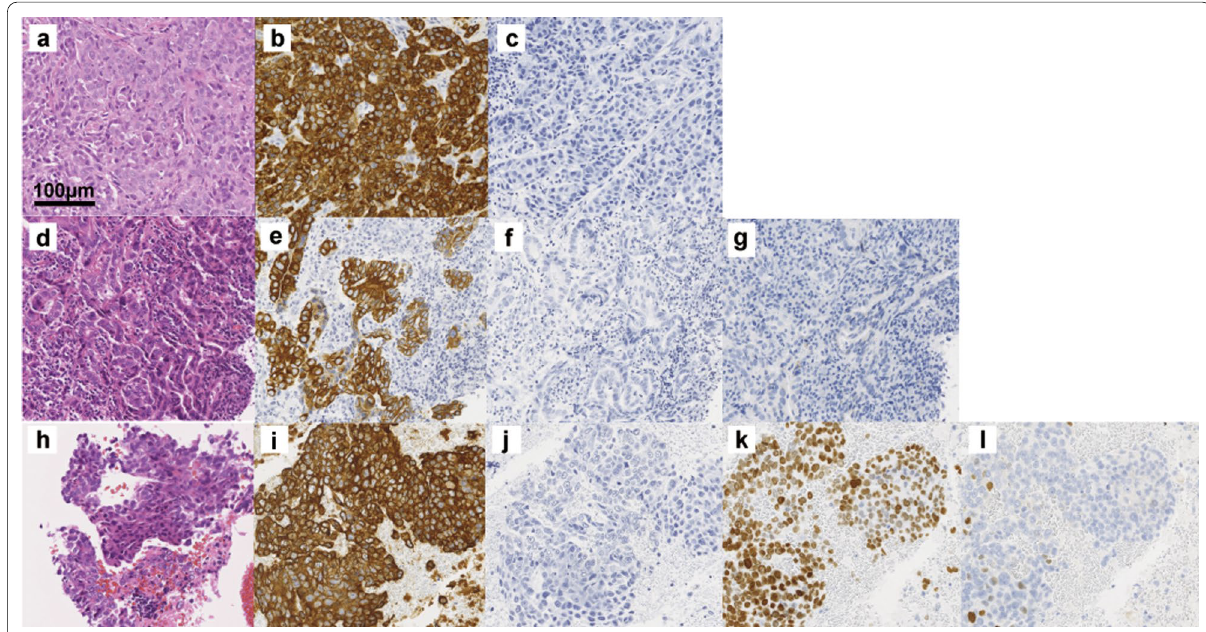
Fig. 1 Histopathological examination of biopsy specimens. Specimens from a gastric tumor biopsy ( a – c ), lung tumor biopsy ( d – g ), and mediastinal lymph node biopsy ( h – l ). Histopathological examination of the gastric tumor biopsy specimen showed poorly differentiated adenocarcinoma (hematoxylin–eosin staining) ( a ). The tumor cells of the gastric tumor were positive for cytokeratin (CK)7 ( b ) and negative for CK20 ( c ). Biopsy of the lung tumor showed invasive adenocarcinoma (hematoxylin–eosin staining) ( d ). Part of the tumor was tubular adenocarcinoma with mucus production. The tumor cells of the lung tumor were positive for CK7 ( e ), negative for CK20 ( f ), and negative for TTF-1 ( g ). Biopsy of the mediastinal lymph node showed poorly differentiated adenocarcinoma without a gland duct (hematoxylin–eosin staining) ( h ). The tumor cells of the